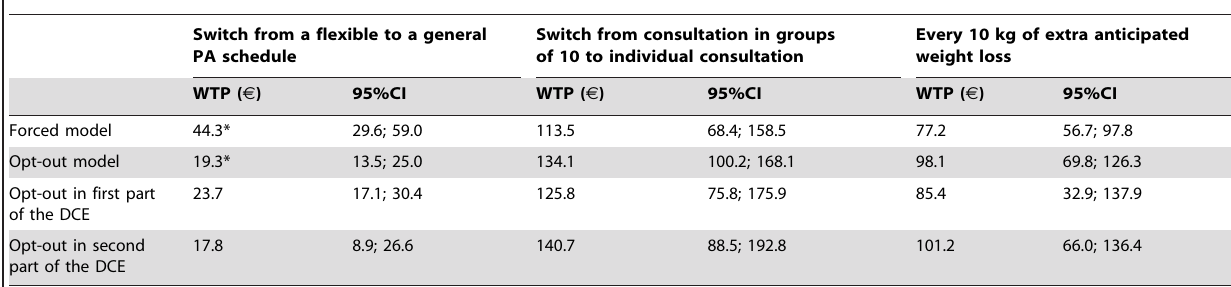
Table 5. Willingness to pay values for all tested models from table 3 and 5.